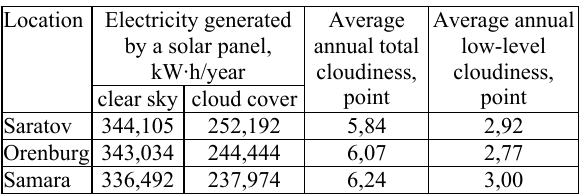
Table 2. Estimates of solar energy potential and cloudiness for